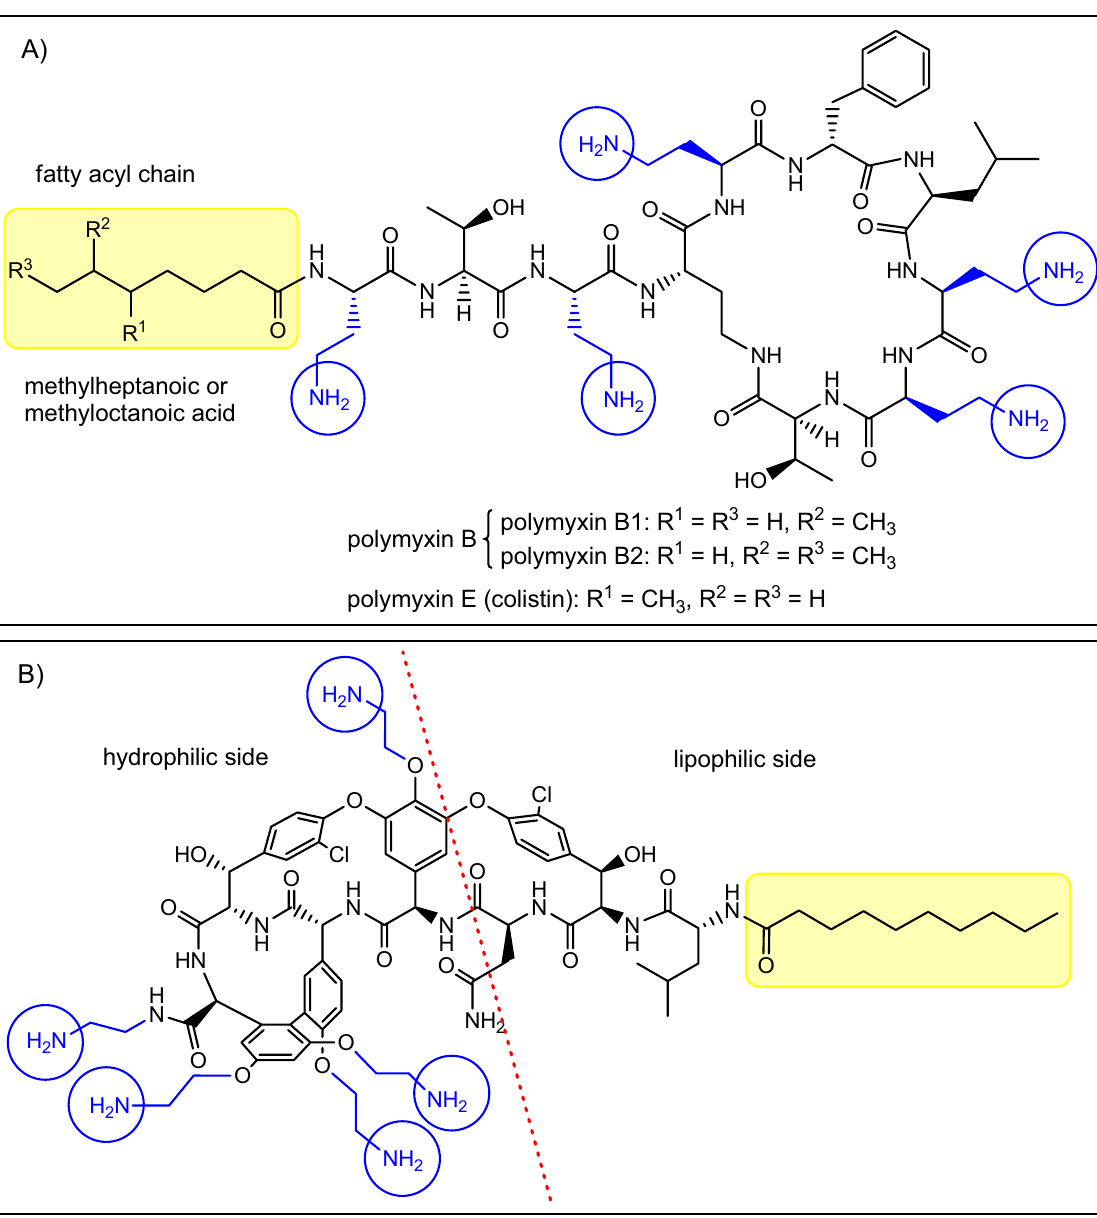
Figure 1. ( A ) The structure of polymyxins. ( B ) Target compound with five primary amino groups and a fatty acyl side